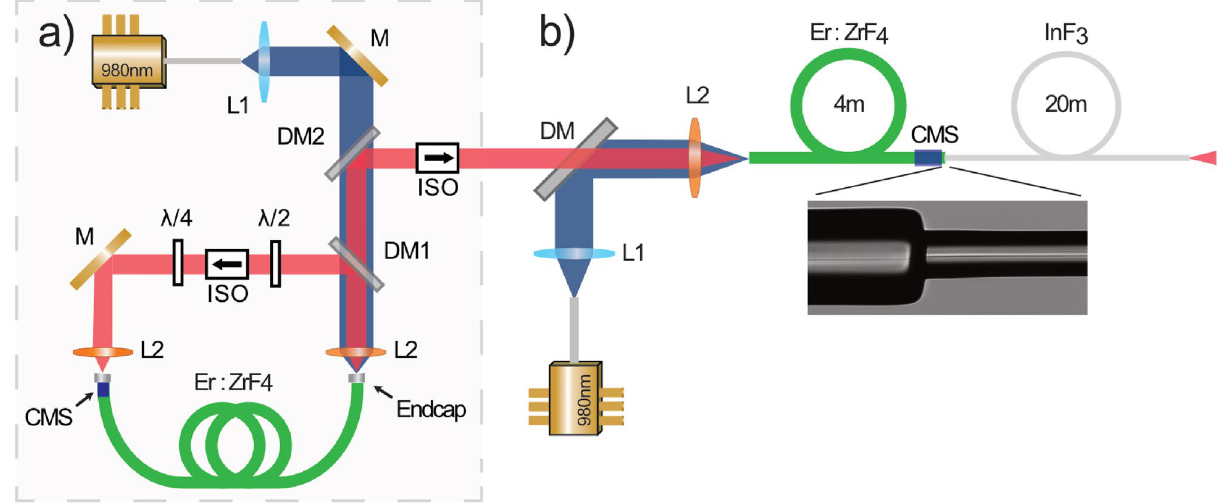
Figure 1. Schematic of the experimental setup. The spectral tuning is selected via the 980 nm pump power which controls the amplification process, and thus the achievable redshift. ( a ) 2.8 µm mode-locked fiber laser ( b ) SSFS module. Abbrev. M : Gold Mirror; L1 : Silica; L2 : AR-coated ZnSe; CMS : Cladding Mode Stripper; DM : Dichroic Mirror; ISO :